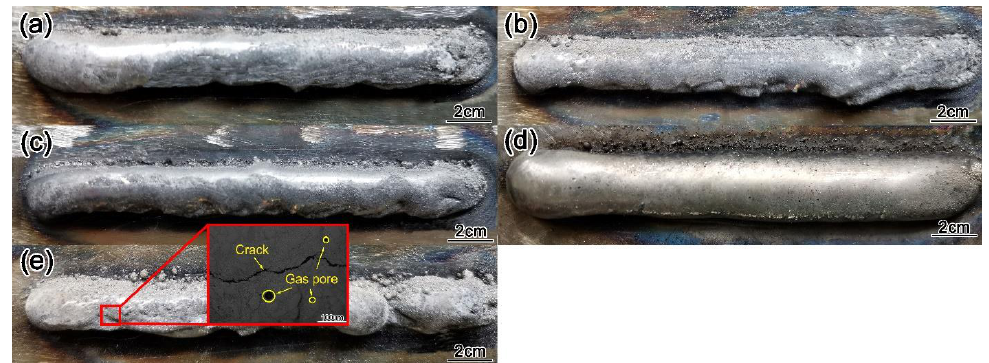
Figure 5. Macro morphology of surfacing layer with different content of Y 2 O 3 ( a ) 0 wt.%, ( b ) 0.4 wt.%, ( c ) 0.8 wt.%, ( d ) 1.2 wt.%, and ( e ) 1.6 wt.%